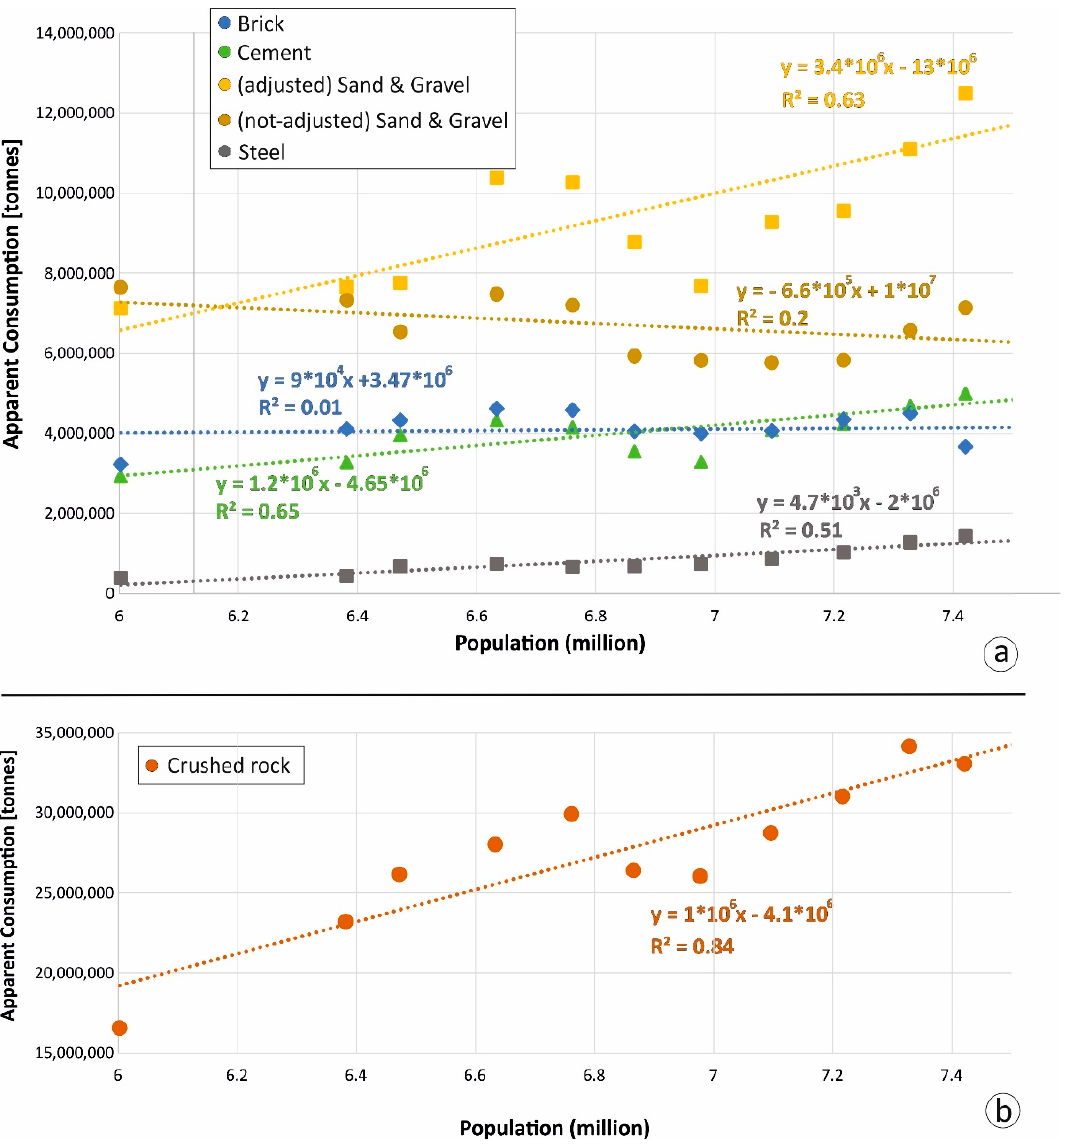
Figure 8. Correlation between population and AC of bricks, cement, (adjusted) sand & gravel, (not-adjusted) sand & gravel and steel ( a ) and crushed rock aggregates ( b ). Note: a different scale for the consumption projection of crushd rock is used. Linear fitting equations and R 2 values for each variable are provided.